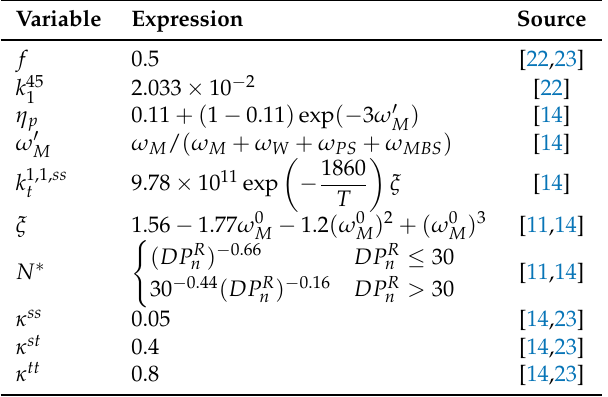
Table 5. Auxiliary variables for the computation of the rate constants.